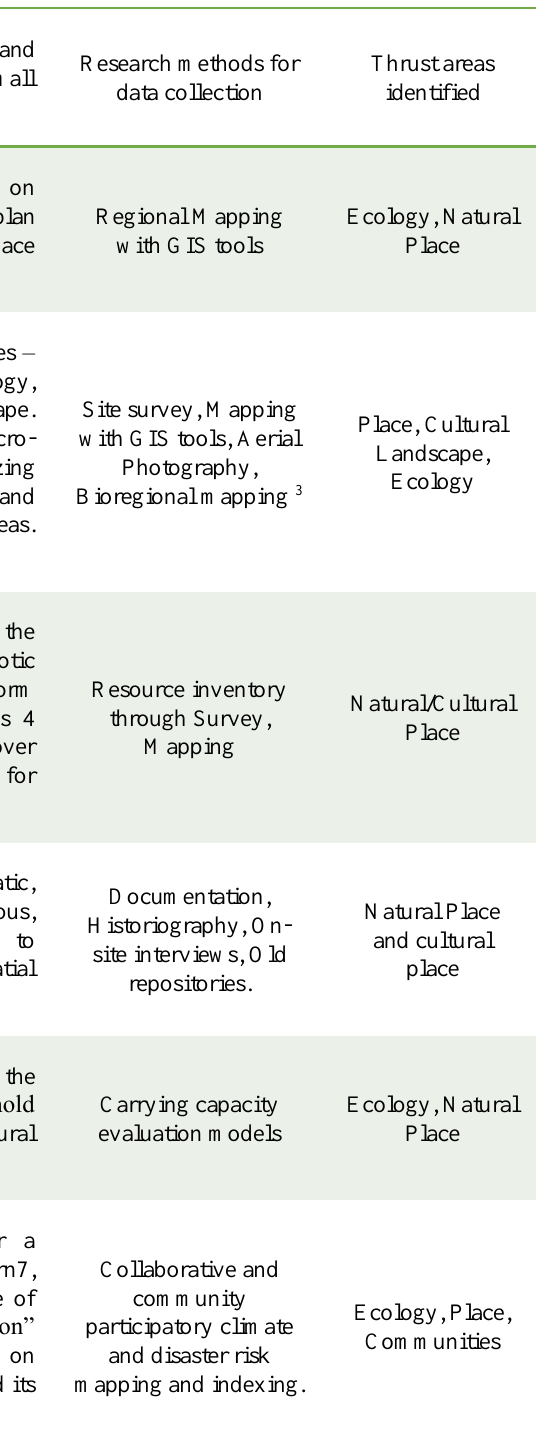
Table 2. Indicative parameters and a framework for bioregionalistic vision for small towns.